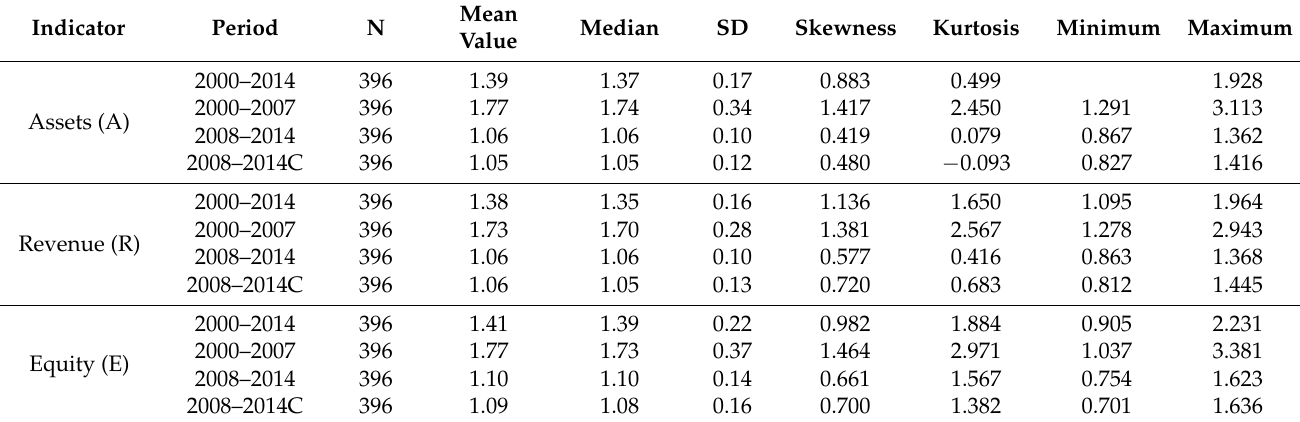
Table 2. Normality distribution for economic and financial indicators indices by different time periods.